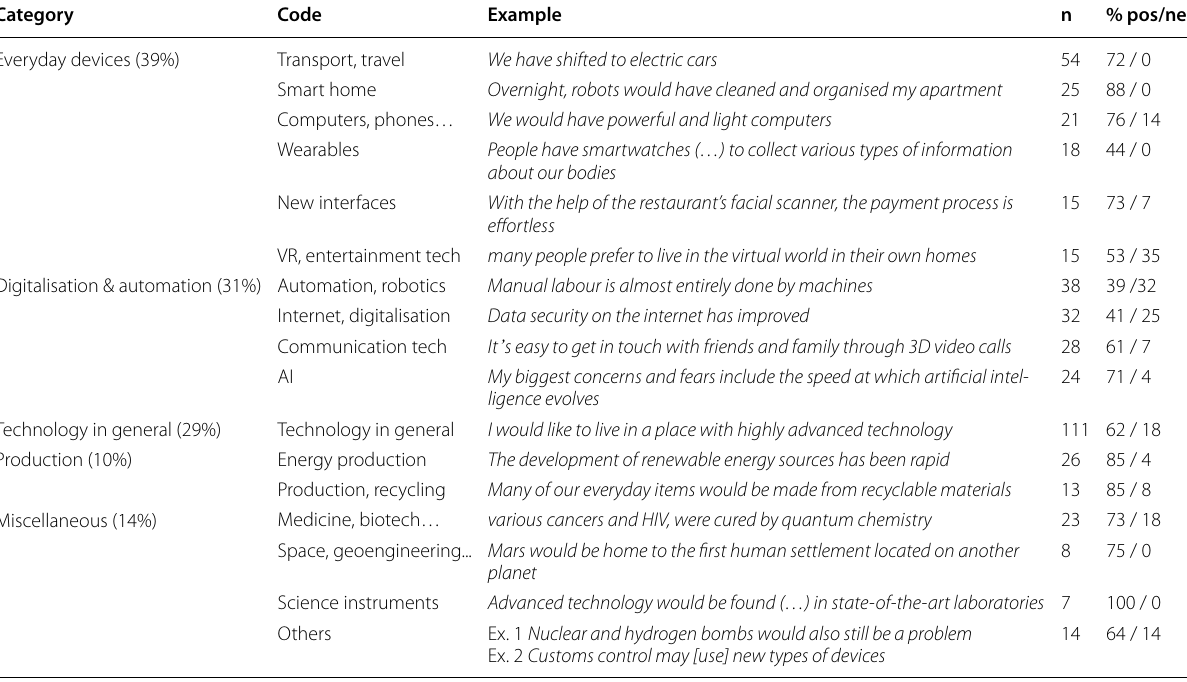
Table 1 Technology codes that emerged from the analysis, grouped into categories. In addition, illustrative examples, number of occurrences and percentages of positive and negative framings are given (any remaining occurrences were coded as